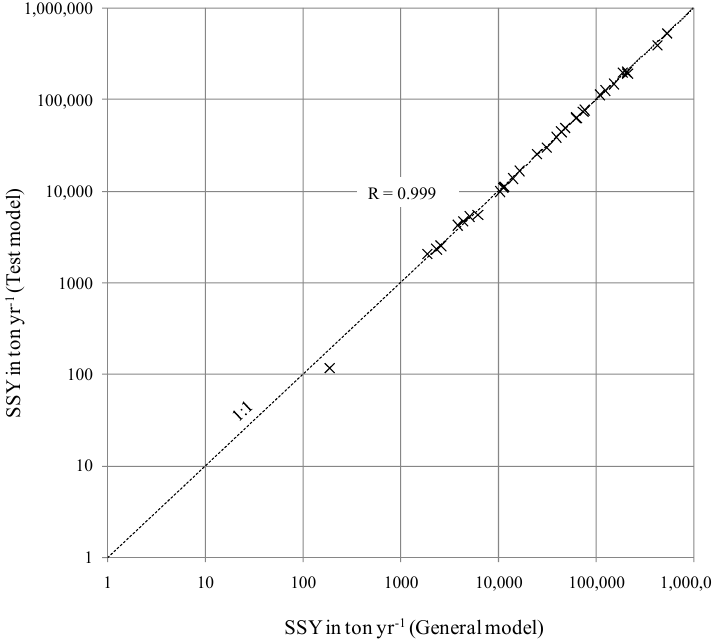
Figure 3. Scatter plot of the SSY results of the general model and Equation (7) versus the test